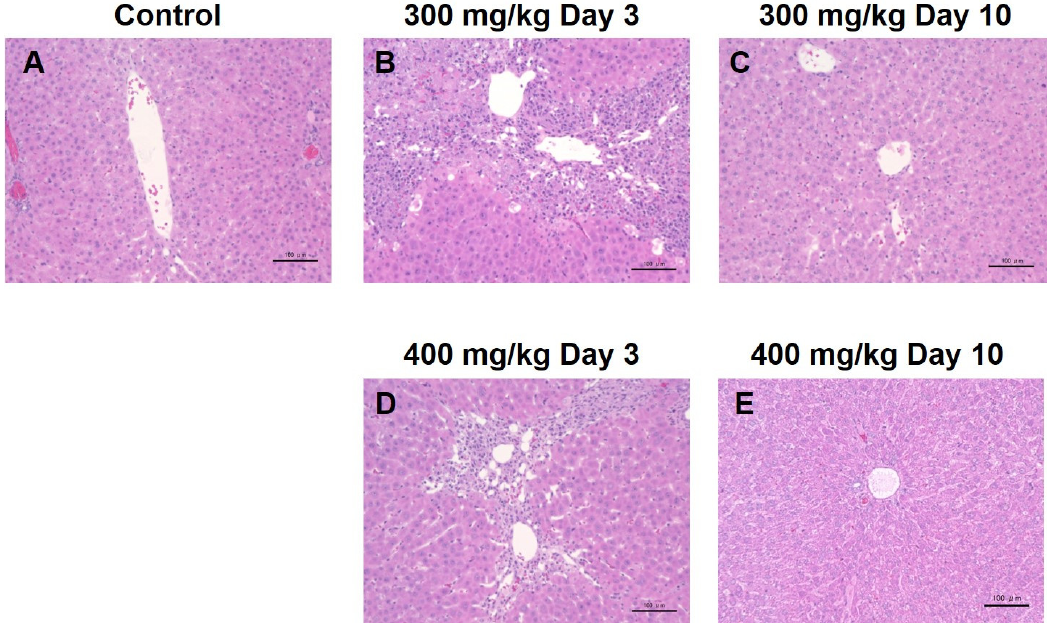
Figure 7. ( A – E ) show H&E stainings of the livers from control and TAA-injected rats. H&E, hematoxylin and eosin, TAA, thioacetamide.